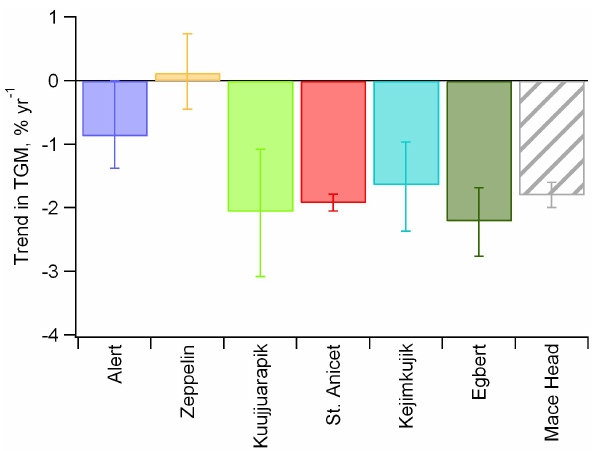
Fig. 3. Trends in TGM at all sites for 2000–2009 and Mace Head, Ireland for 1996–2009. Error bars represent 95% confidence limits.